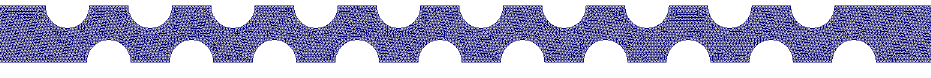
Figure 2. Computational